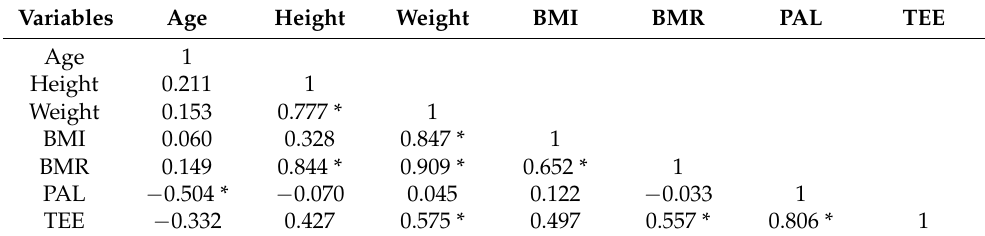
Table 4. Correlations between physical measures and energy